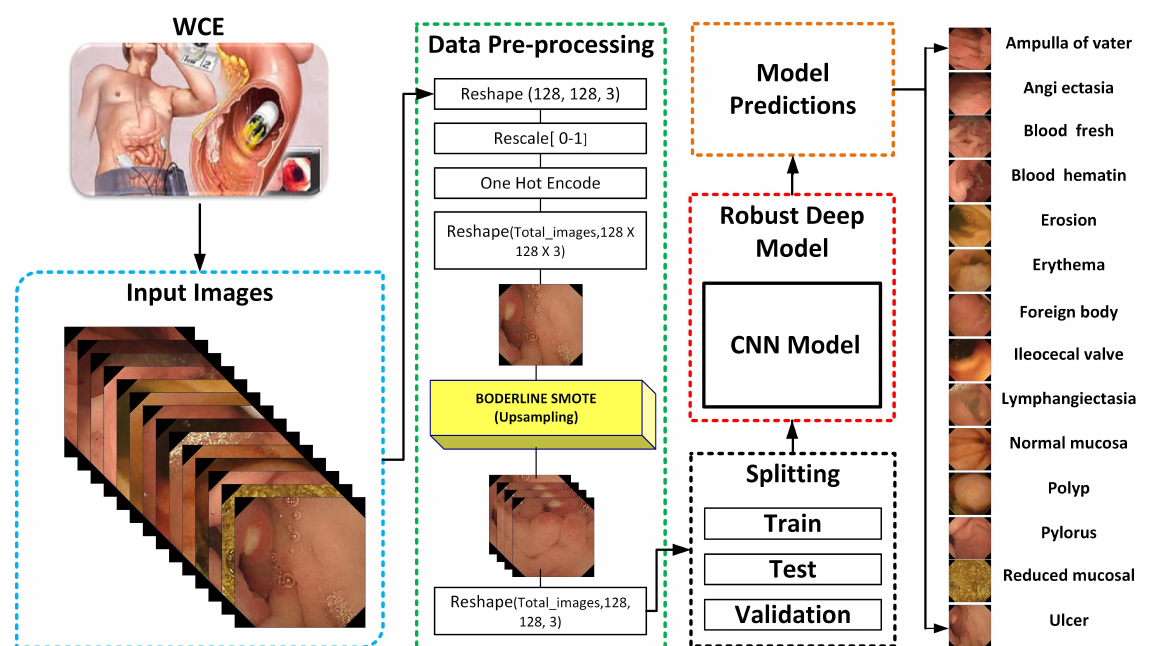
Figure 1. Work flow of the proposed classification model for